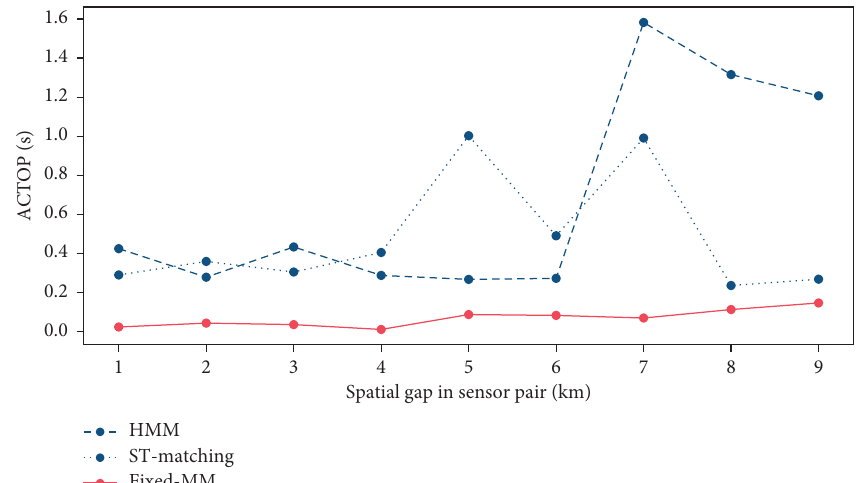
Figure 12: ACTOP with respect to the spatial gap (all algorithms are run on a Mac with 2.2GHz Intel CPU and 16GB